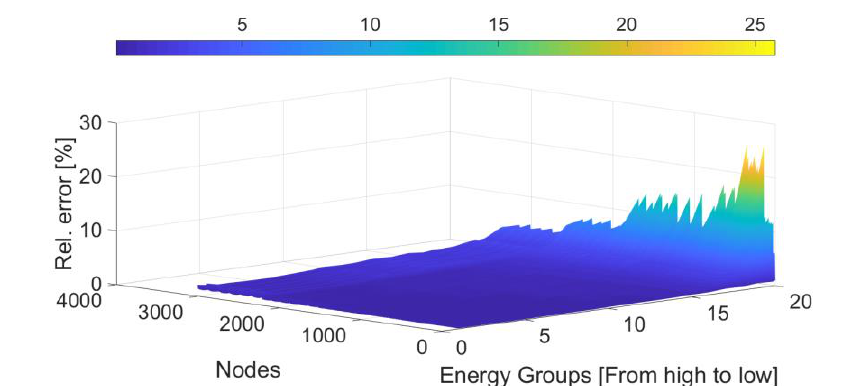
Figure 5. Relative error (%) of the multi-group total cross-section at all nodes After processing all the correspondent nodal cross-sections and re-building a homogenized core, the MGMC capabilities offered by OpenMC gave an eigenvalue of (cid:2) (cid:3)(cid:4)(cid:4) = 1.04902 ± 3 (cid:5)(cid:6)(cid:7) (after 5(cid:8) (cid:10) histories along 250 active cycles). Compared to the heterogeneous reduced case, the difference between eigenvalues is ∆(cid:2) (cid:3)(cid:4)(cid:4) = 489 (cid:5)(cid:6)(cid:7) ± 1 (cid:5)(cid:6)(cid:7)